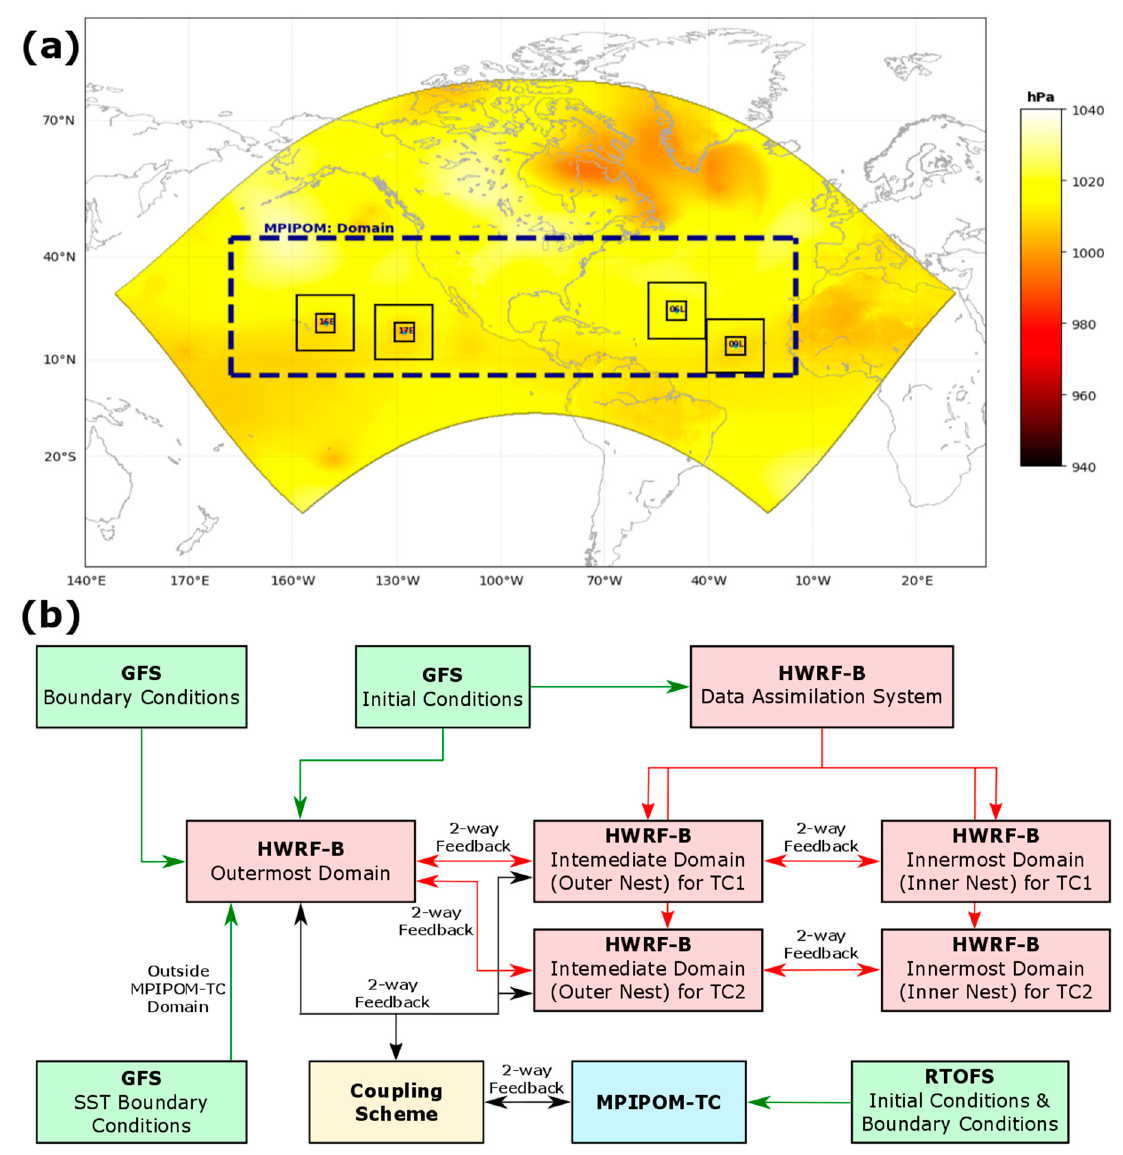
Figure 1. ( a ) Mean sea-level pressure (shaded) within the outermost domain of the atmosphere model, the Basin-scale Hurricane Weather Research ad Forecasting (HWRF-B) model. The domain of the ocean model, the Message Passing Interface Princeton Ocean Model for Tropical Cyclones (MPIPOM-TC), is outlined with a dashed black line. Moving nests (two per storm) are shown for four storms. ( b ) The schematic shows the model tree for the entire HWRF-B modeling system, specifically: HWRF-B (red; the atmosphere model), MPIPOM-TC (blue; the ocean model), the multi-storm coupling scheme (yellow), and initial / lateral boundary conditions (green), including the Global Forecast System (GFS) and the Global Real-Time Ocean Forecast System (RTOFS). Arrows show the flow of data: green arrows represent initial / lateral boundary conditions, red arrows represent internal data flow within HWRF-B, and black arrows represent data transferred by the coupling scheme. The schematic shows a forecast with two storms: tropical cyclone 1 (TC1) and tropical cyclone 2 (TC2).